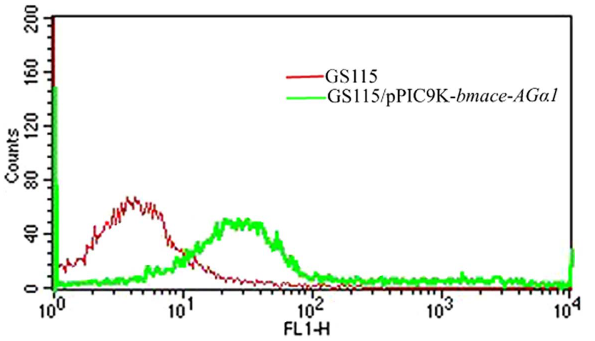
Figure 4. Flow cytometry detection of Bm AChE displayed on the recombinant yeast surface.